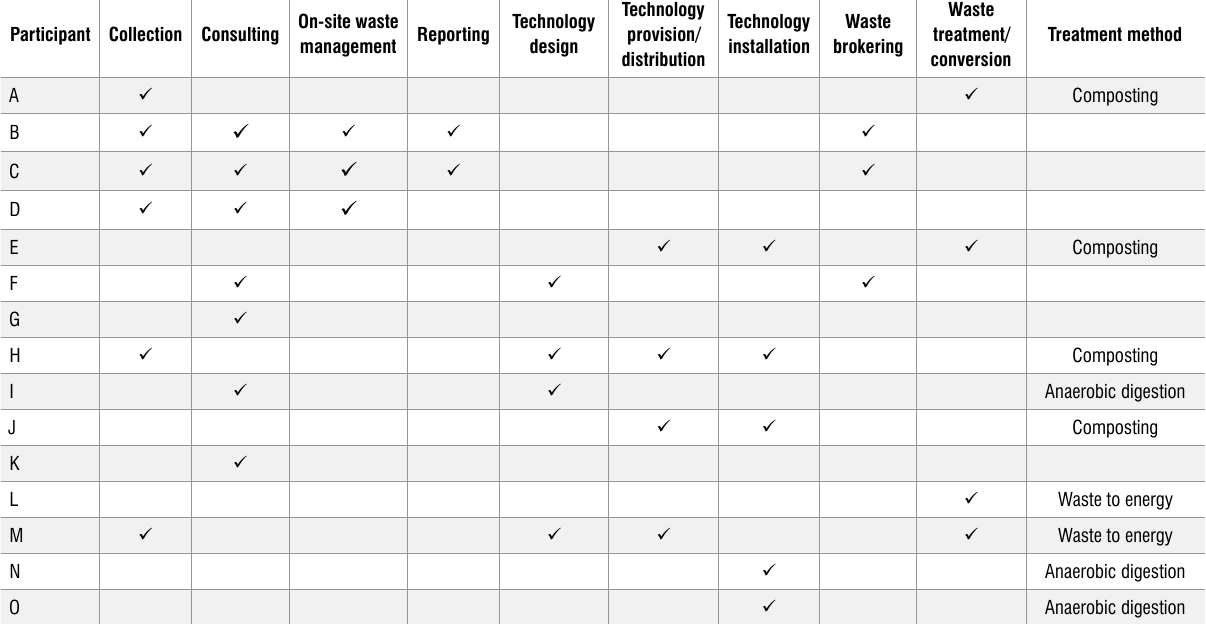
Technology Technology On-site waste Reporting design management